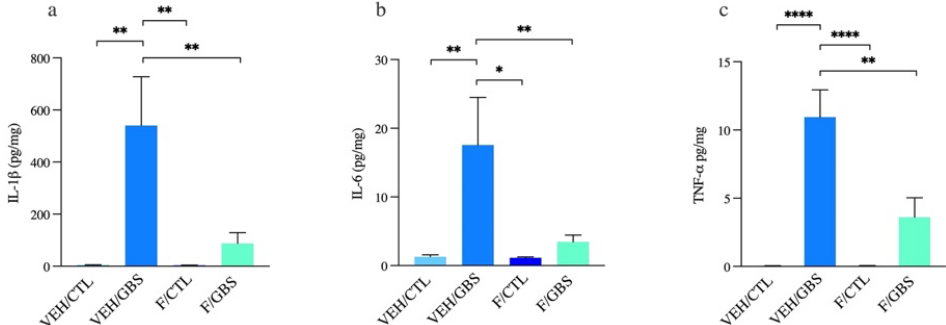
Figure 3. In combination with flutamide, GBS-induced chorioamnionitis is associated with decreased levels of placental proinflammatory cytokines IL-1 β , IL-6 and TNF- α . Mean placental concentrations of ( a ) IL-1 β , ( b ) IL-6, ( c ) TNF- α detected by ELISA post-GBS inoculation. Analyses were done by one-way ANOVA with Dunnett’s multiple comparison (to vehicle/GBS). Bars represent mean ± SEM. Number ( n ) of placentas in vehicle/control: n = 6, vehicle/GBS: n = 5, flutamide/control: n = 5, flutamide/GBS: n = 5. One male placenta was used per litter. * p < 0.05, ** p < 0.01, **** p <